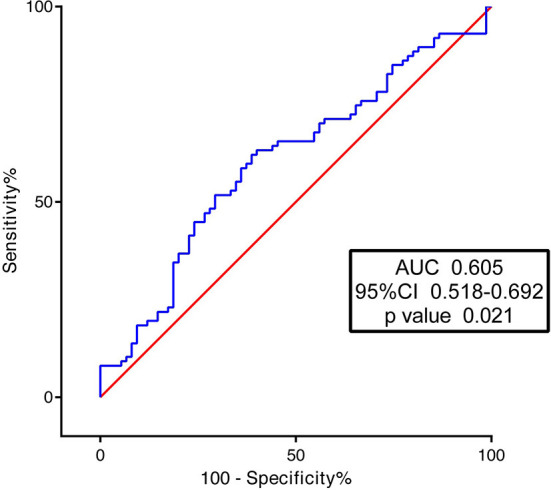
Receiver operating characteristic curves of hyaluronan (HA) for predicting plaque erosion.